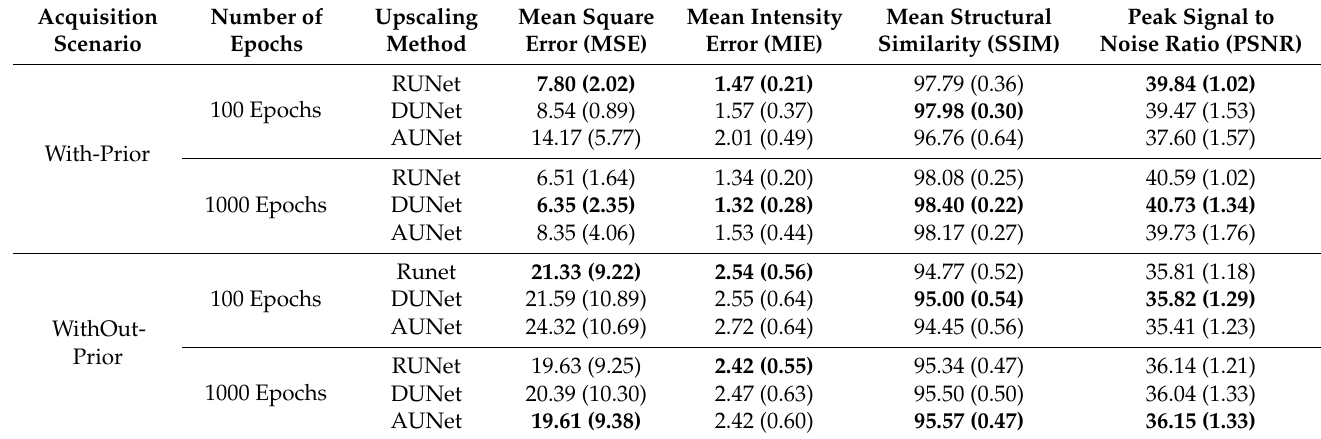
Table 3. Upscaling a 1/2 downsampled (88 × 104) synLQ with the three Unets. The best results are represented in bold. The numbers represent the mean value followed by the standard deviation in